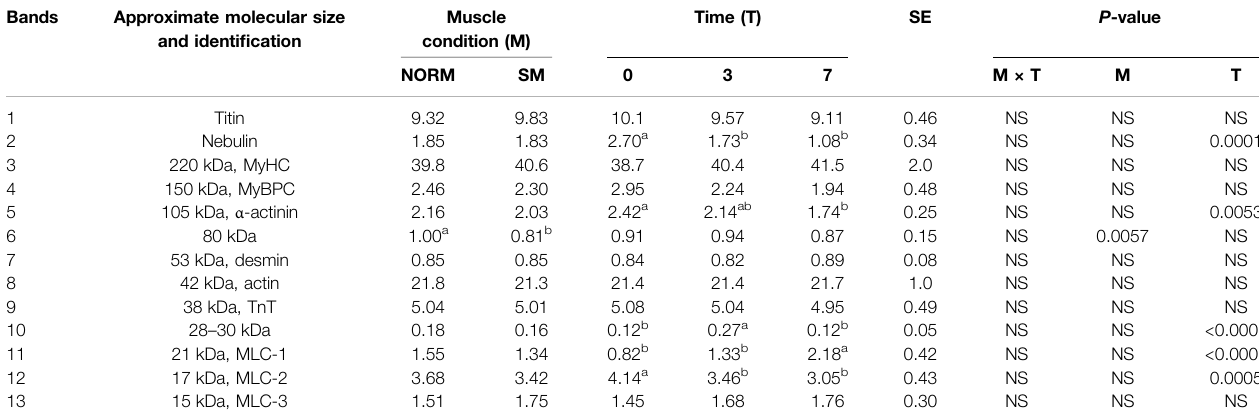
TABLE 1 | Relative abundance 1 of SDS-PAGE protein bands from the myo fi brillar fraction of broiler breast fi llets according to muscle condition (M — normal, NORM; Spaghetti Meat, SM) and postmortem time (T — 0, 3, 7 days). Bands Approximate molecular size Muscle Time (T) and identi fi cation condition (M)